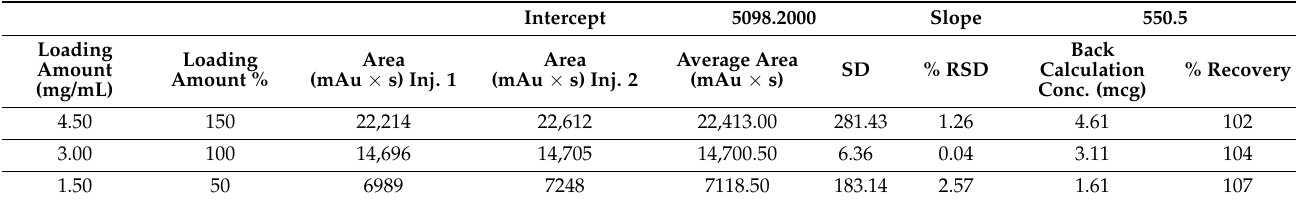
Table 7. Recovery calculation for accuracy data set.